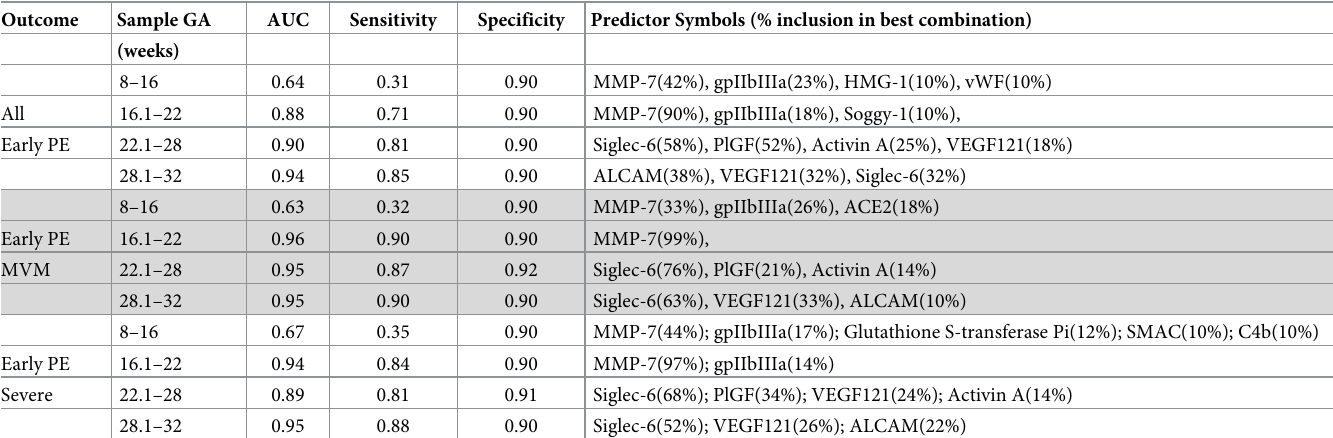
Table 2. Summary of bootstrap results for prediction of early preeclampsia vs normal pregnancy.